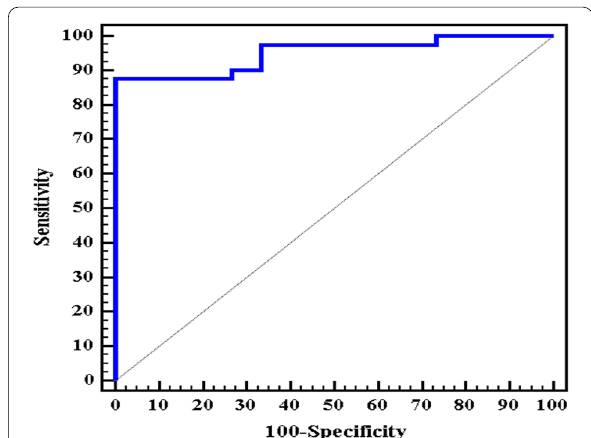
Fig. 2 ROC curve generated for level of WT1 expression among AML patients and